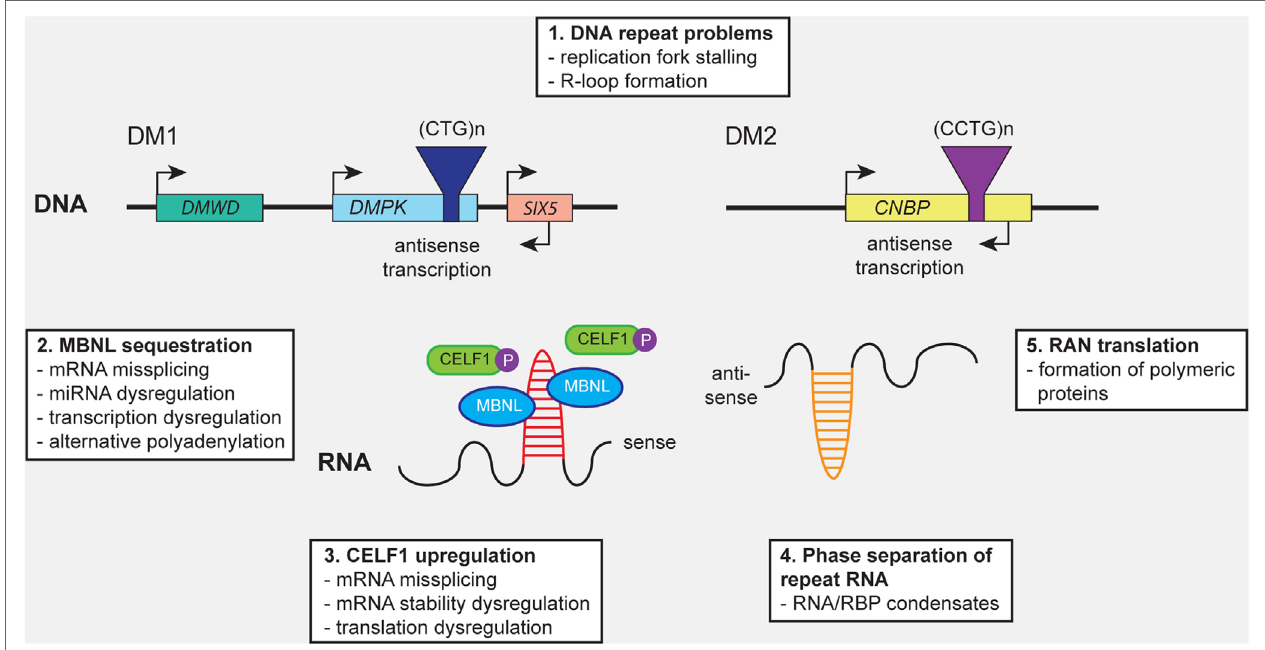
FiGURe 1 | Distinct molecular mechanisms contribute to pathology in myotonic dystrophy type 1 (DM1) and myotonic dystrophy type 2 (DM2). (1) Expanded (CTG)n and (CCTG)n repeats in DMPK and CNBP , or the complementary repeats in the antisense genes (not shown), can cause cellular stress by (1) promoting DNA replication fork stalling and R-loop formation. Expression of repeat-containing sense and antisense RNAs results in (2) sequestration of members of the MBNL protein family, leading to mRNA missplicing, alternative polyadenylation, microRNA (miRNA) deregulation, and transcription deregulation. In addition, (3) CELF1 gets hyperphosphorylated and stabilized, resulting in mRNA missplicing and dysregulation of mRNA stability and translation. (4) Formation of abnormal RNA-protein condensates by repeat RNA and RNA-binding proteins (RBPs) may alter the intracellular distribution fate and biological activity of RBPs. (5) Repeat-associated non-ATG (RAN) translation of the repeats may result in the production of toxic polymeric polypeptides, which perturb cellular proteostasis.